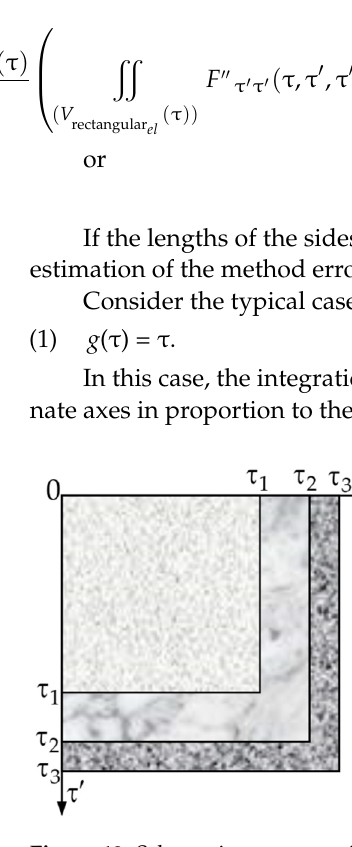
Figure 12. Schematic representation of the set of integration regions in the points τ = τ 1 , τ = τ 2 , τ = τ 3 for g ( τ ) = τ .